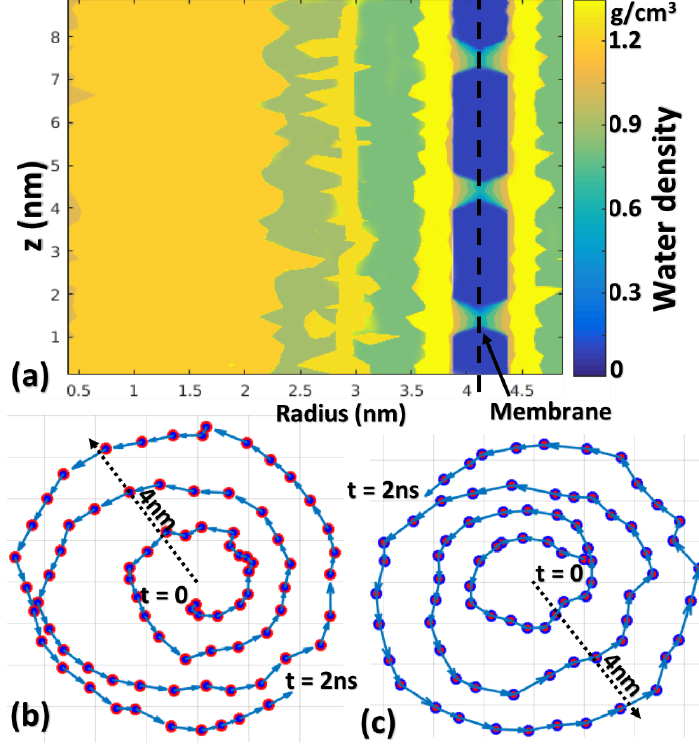
Figure 4. ( a ) Water density profiles of model type II along the radial and longitudinal directions under ω = 17.5 rad/ns (Values along azimuthal direction are averaged). The trajectory of a typical Na + ion ( b ) and Cl − ion ( c ) which are located near the center at t = 0 and move to the membrane wall at t = 2